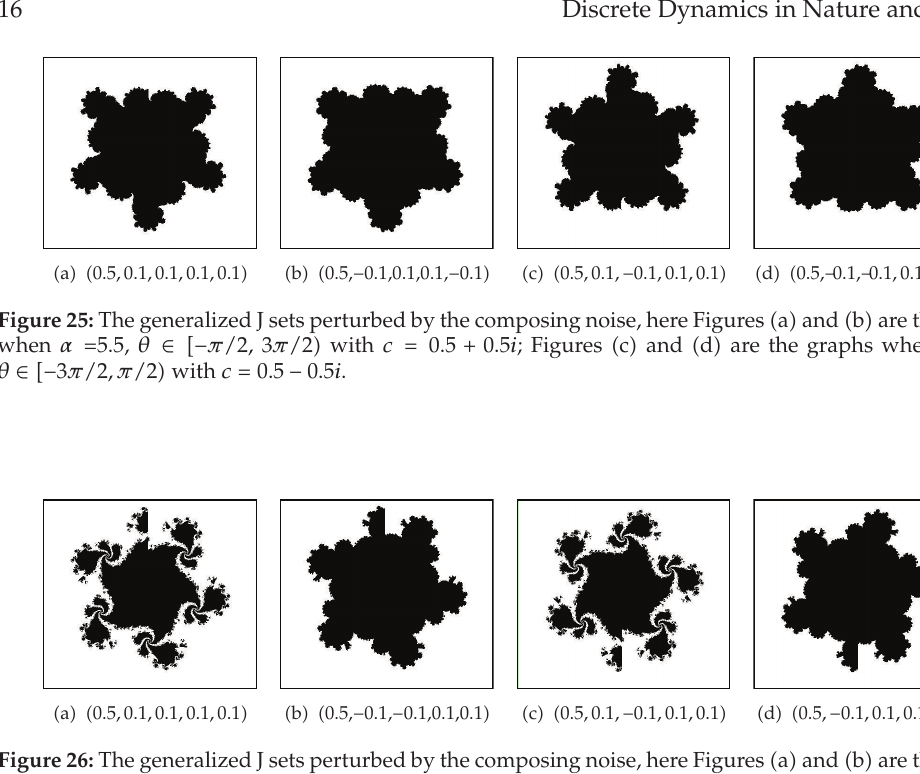
Figure 26: The generalized J sets perturbed by the composing noise, here Figures (cid:3) a (cid:4) and (cid:3) b (cid:4) are the graphs when α (cid:6) 5.5, θ ∈ (cid:7) − π/ 2 , 3 π/ 2 (cid:4) with c (cid:6) − 0 . 5 (cid:5) 0 . 5 i , Figures (cid:3) c (cid:4) and (cid:3) d (cid:4) are the graphs when α (cid:6) 5.5, θ ∈ (cid:7) − 3 π/ 2 ,π/ 2 (cid:4) with c (cid:6) − 0 . 5 − 0 . 5 i